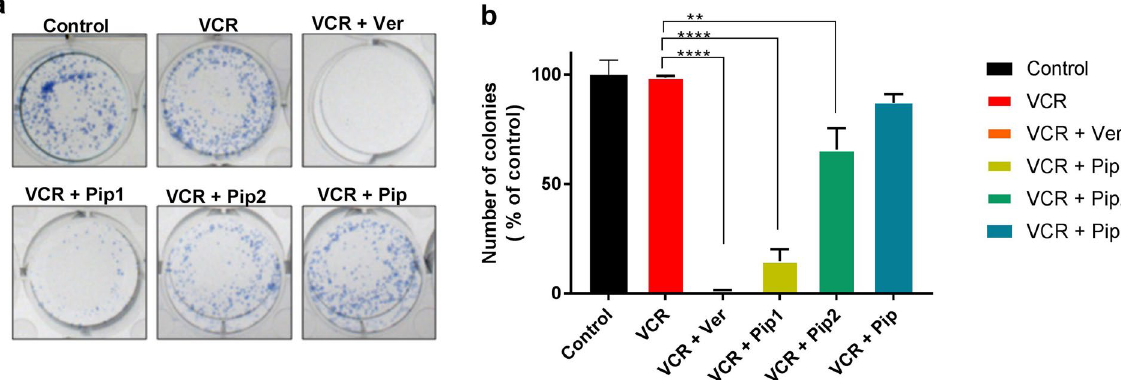
Figure 8. Colony forming ability of resistant KB Ch R 8–5 cells. ( a ) The cells were treated with vincristine (VCR; 5 nM) alone or in combination with 2 μ M each of verapamil (Ver), piperine (Pip), Pip1, and Pip2 for 72 h. Cells incubated only with culture media served as a control. ( b ) Quantification of number of colonies formed, as a percentage of control treatment. Error bars represent standard error of mean (SEM) of three independent experiments. ** p < 0.05 and **** p < 0.0001 versus VCR 5 nM